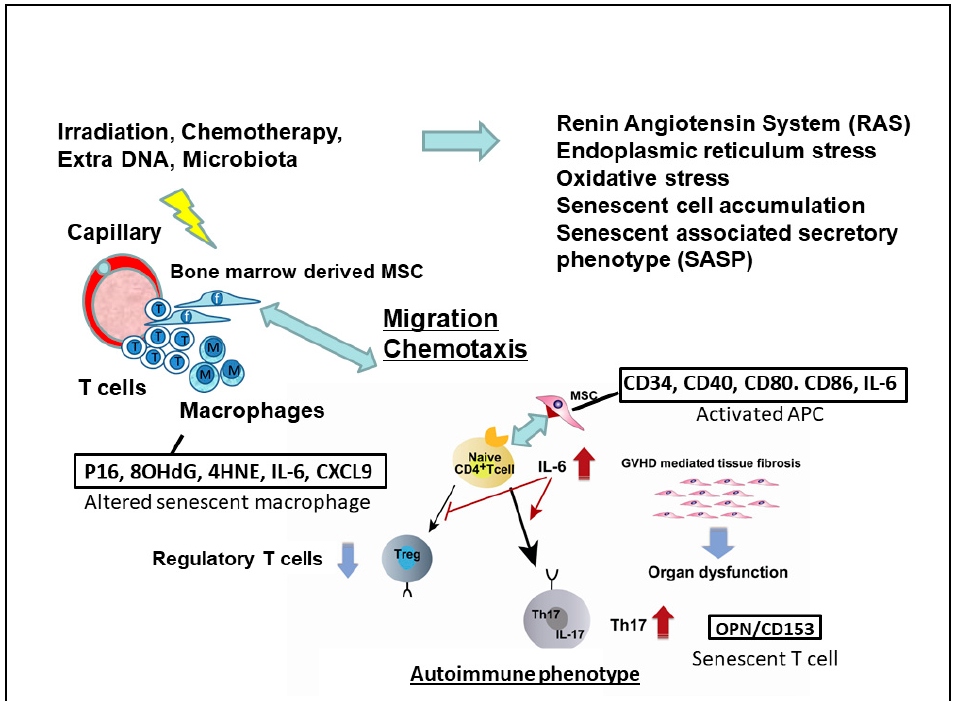
Figure 2. Migration of senescent macrophages play a key role in ocular GVHD. A pro-inflammatory state related to the conditioning regimen, and previous acute GVHD, may lead to an accumulation of cell debris, resulting in the activation of RAS, ER stress, oxidative stress, and senescent cell involving SASP accumulation on the ocular surface and in the lacrimal gland. 8-OHdG; 8-hydroxy-2 ′ -deoxyguanosine, 4-HNE; 4-hydroxy-2-nonenal, HEL; hexonoyl lesion, IL-6, interleukine-6, CXCL9; C-X-C motif ligand 9, OPN; osteopontin, CD; clustered of differentiation.